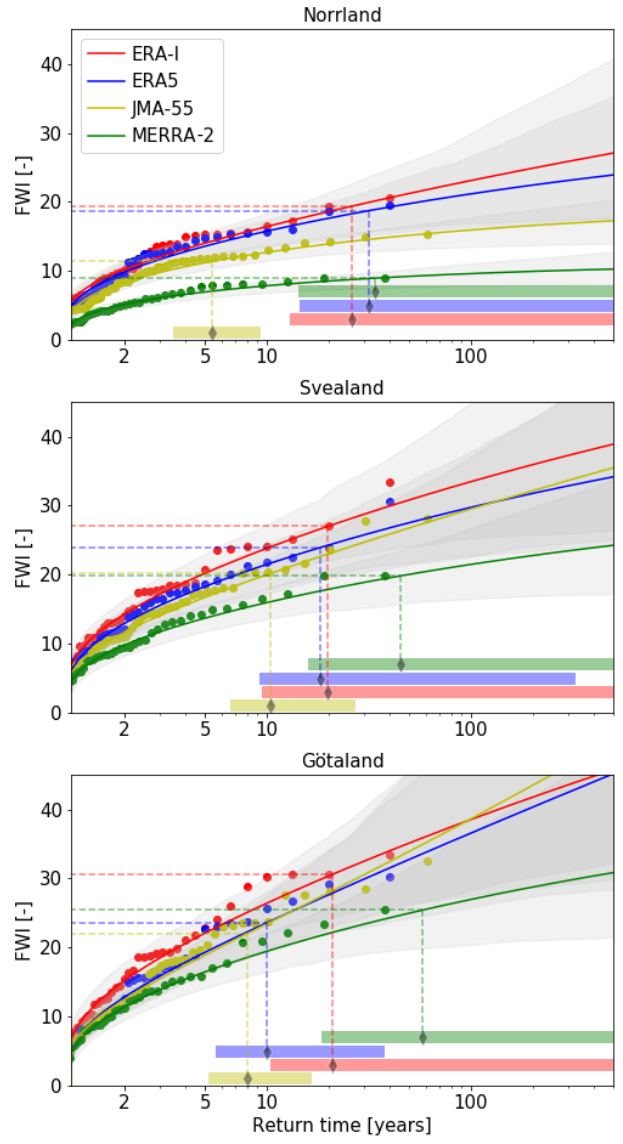
Figure 6. Return times of July–August maximum FWI values, for all four reanalysis data sets and the three regions. The dots repre- sent the actual FWI maximum values, and the lines represent the GEV model fit, with a 5% to 95% uncertainty band in grey. The dashed horizontal lines represent the 2018 event, while the vertical line represents the associated return time, with the horizontal bars giving the 5% to 95% uncertainty estimate (estimated with a non- parametric